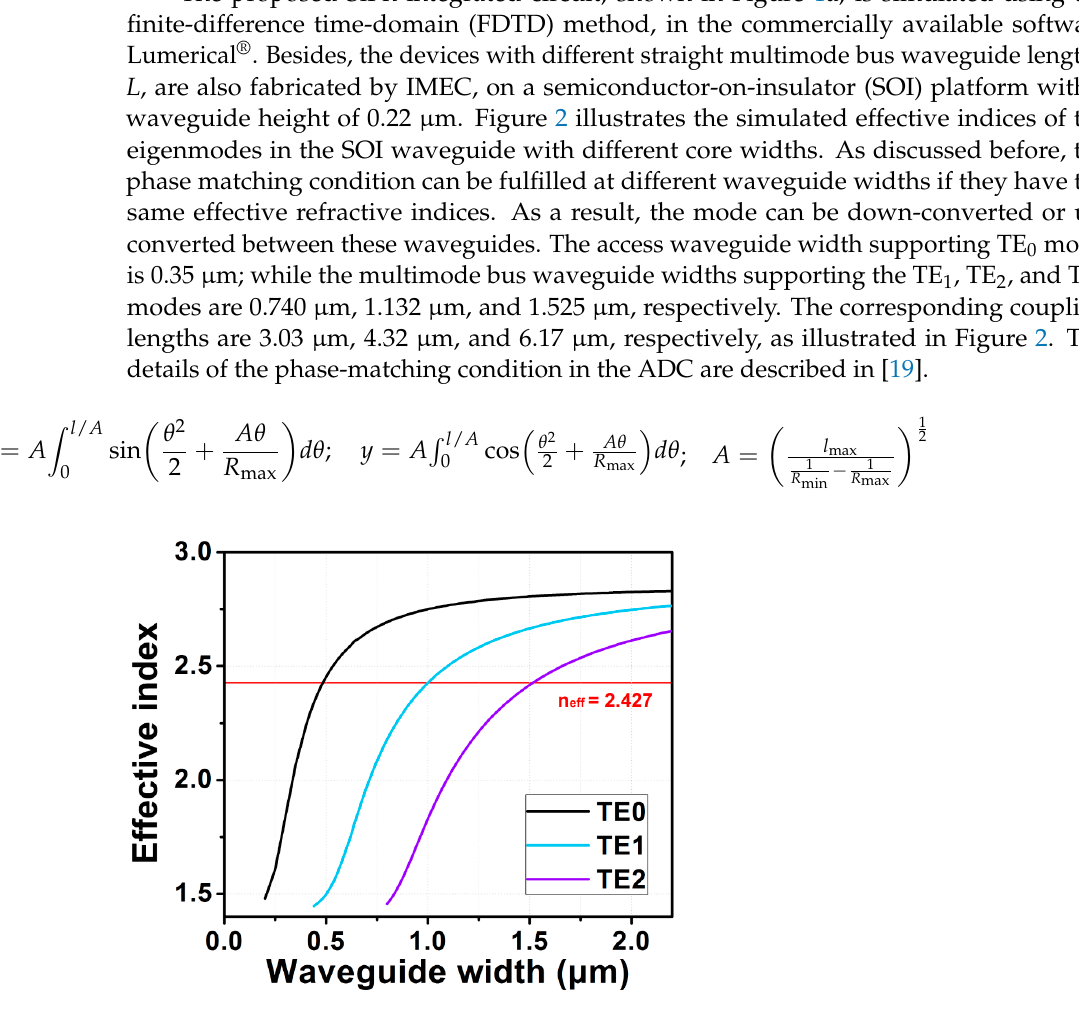
Figure 2. Waveguide effective indices at different waveguide widths for providing phase matching for the MDM Mux/Demux.